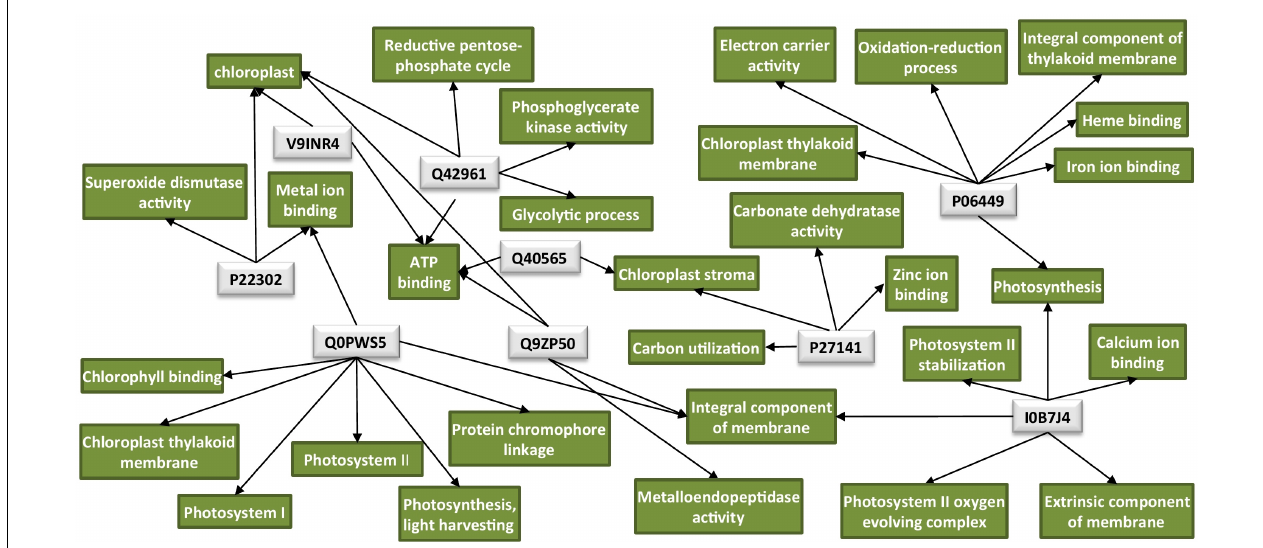
FIGURE 2 | Protein network analysis of the chloroplastic proteins downregulated by TMV. Light-gray rectangles: UniProt protein IDs (Q40565: RuBisCO activase 2, V9INR4: RuBisCO activase 2, Q42961: phosphoglycerate kinase, P06449: cytochrome f, Q0PWS5: chlorophyll a–b binding protein, P27141: carbonic anhydrase,